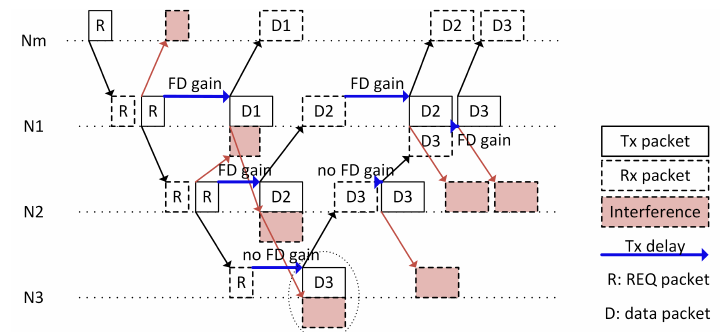
Figure 3. FD-LTDA-MAC schedules in a three-hop